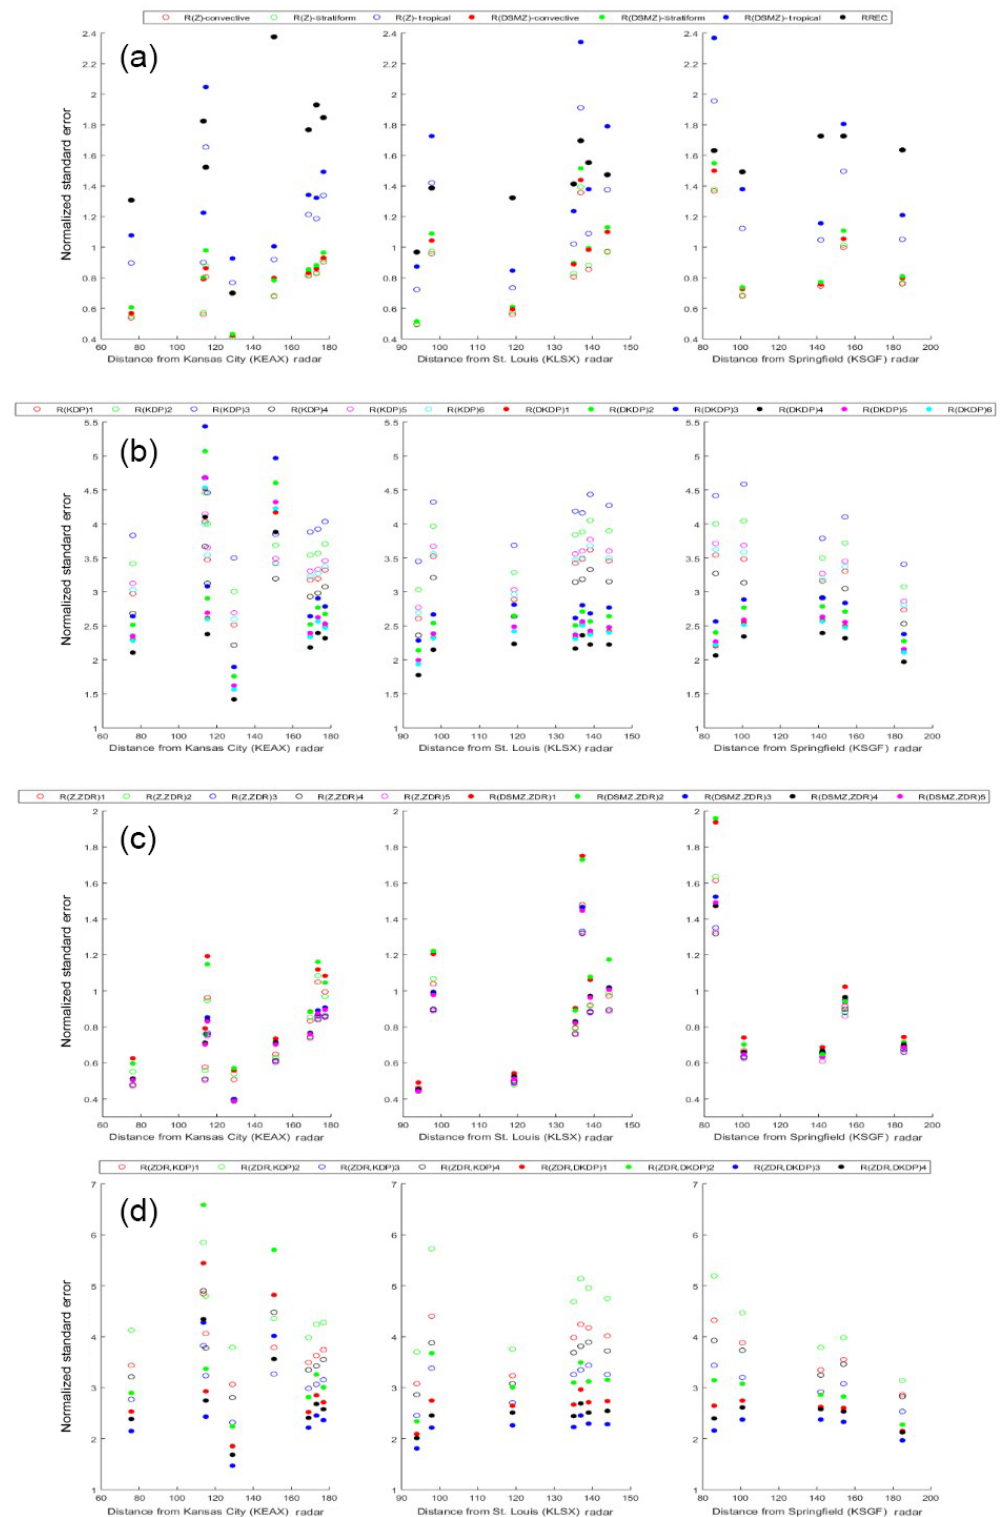
Figure 2. Normalized standard error values for the overall performance of the (a) 3 R(Z) , 3 R (DSMZ), and RREC algorithms; (b) 6 R (KDP) and 6 R (DKDP) algorithms (algorithms 1–6 from Table 2); (c) 5 R ( Z ,ZDR) and 5 R (DSMZ,ZDR) algorithms (Eqs. 7–11 from Table 2); and (d) 4 R (ZDR,KDP) and 4 R (ZDR,DKDP) algorithms (Eqs. 12–15 from Table 2) for the three radars utilized for the current